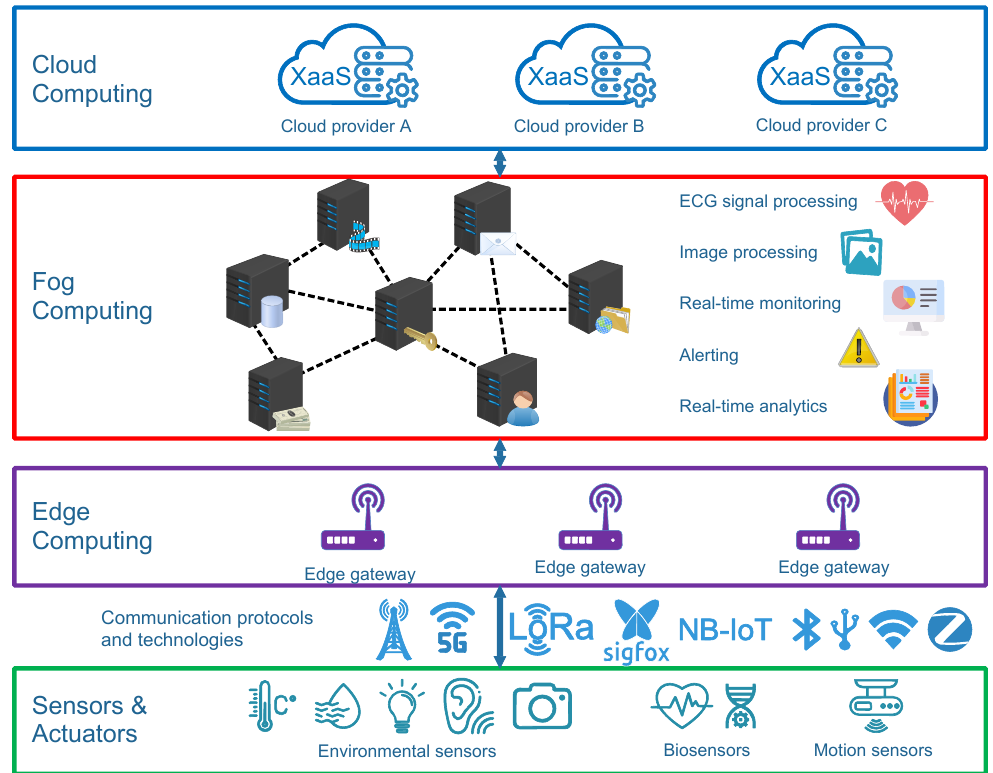
Figure 5. Fog–cloud-based architecture for